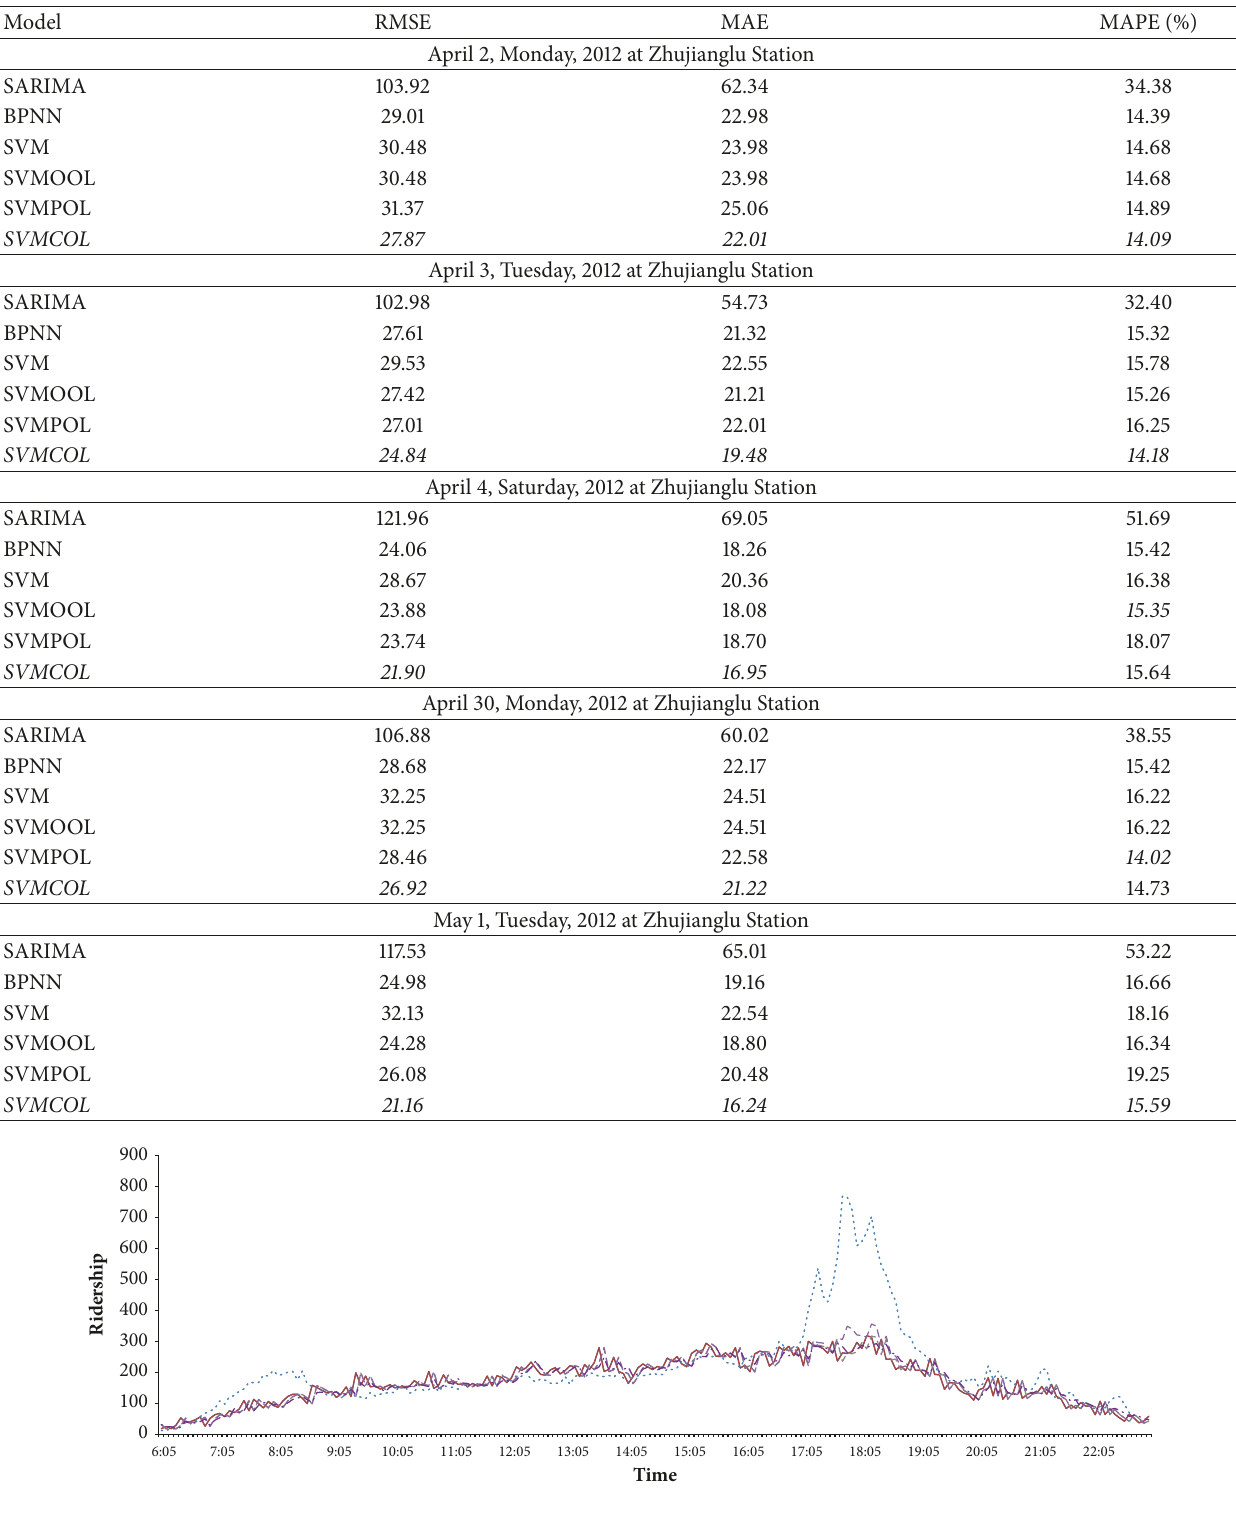
Table 4: Ching-Ming Festival and May Day performance comparison for one-step prediction.